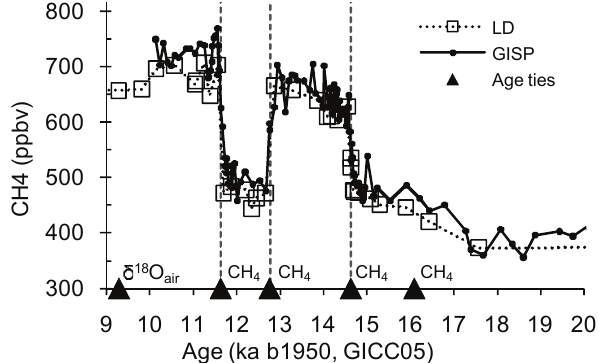
Fig. 2. Dating of the LD ice core through the deglaciation. LD methane is synchronised with GISP2 methane (Blunier and Brook, 2001) on the GICC05 timescale. Timing of methane transitions at the onset of the Bølling, Younger Dryas, and Holocene are shown as dashed vertical lines. Triangles mark the position and type of the dating ties used through the deglaciation. Standard error in LD methane concentrations are ≤